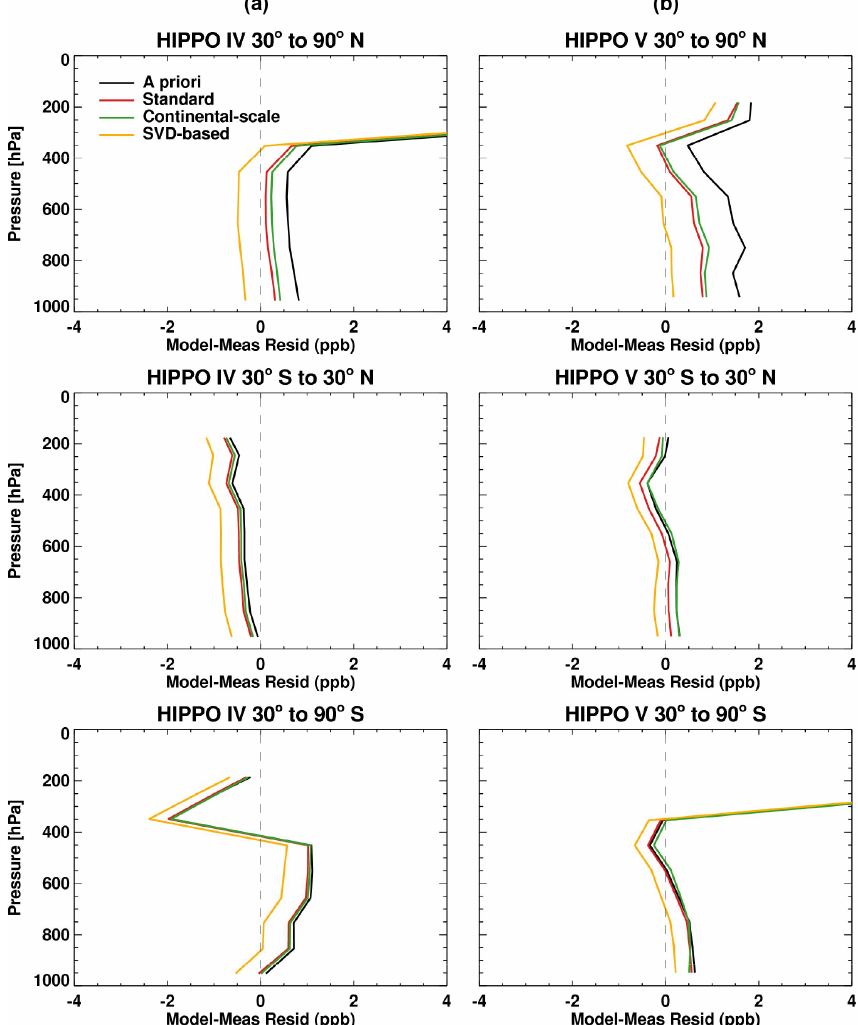
Figure 4. A posteriori evaluation of N 2 O inversion results using HIPPO data (not themselves used in the inversion). Shown are mean vertical profiles of the model–measurement difference for HIPPO IV (a) , 14 June–11 July 2011 and HIPPO V (b) , 9 August–9 September 2011 as a function of latitude. A priori results are shown in black and a posteriori results in red (standard 4D-Var inversion), green (continental-scale inversion), and gold (SVD-based